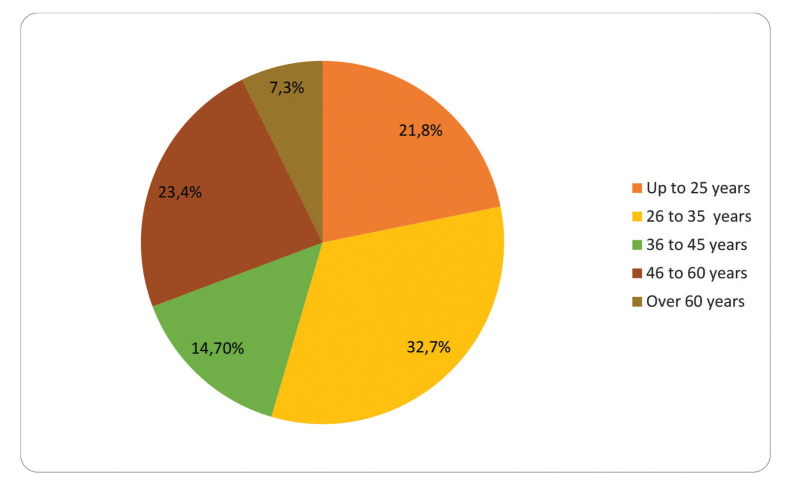
Age distribution.